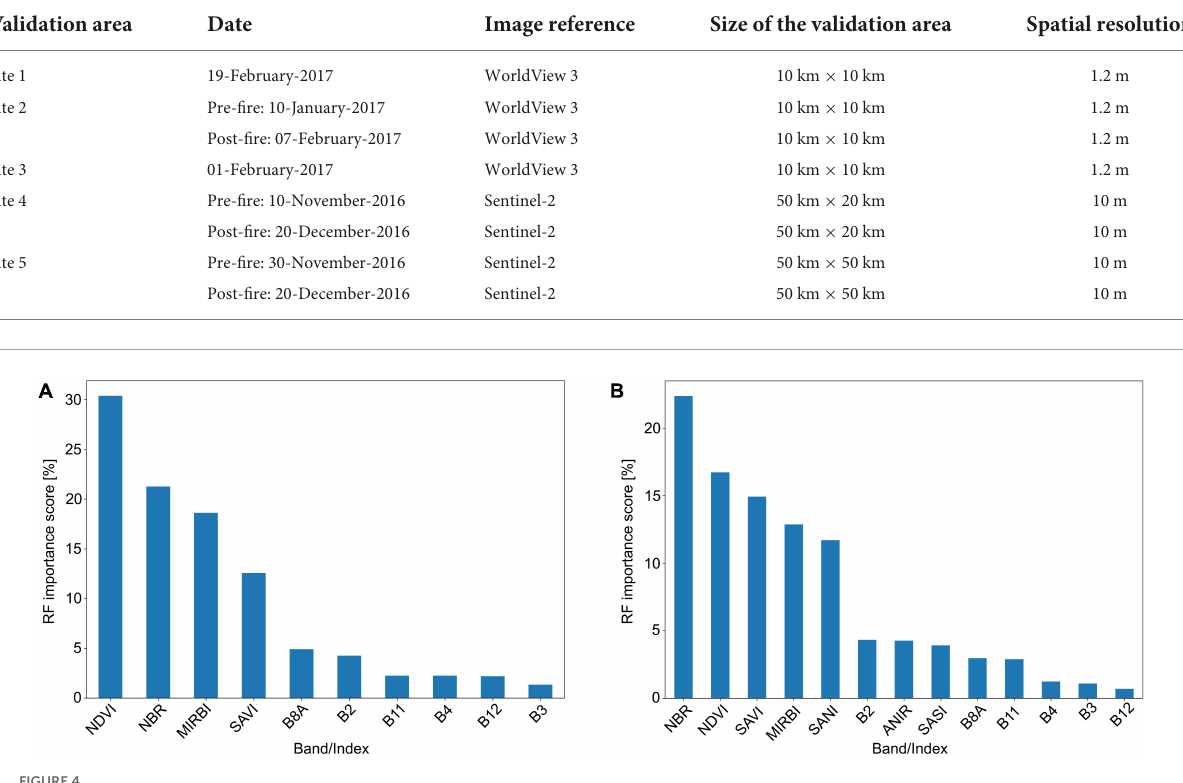
FIGURE4 Random forest importance index of each of the variables included in the algorithm calibration. (A) Importance index of M1, (B) importance index of M2.